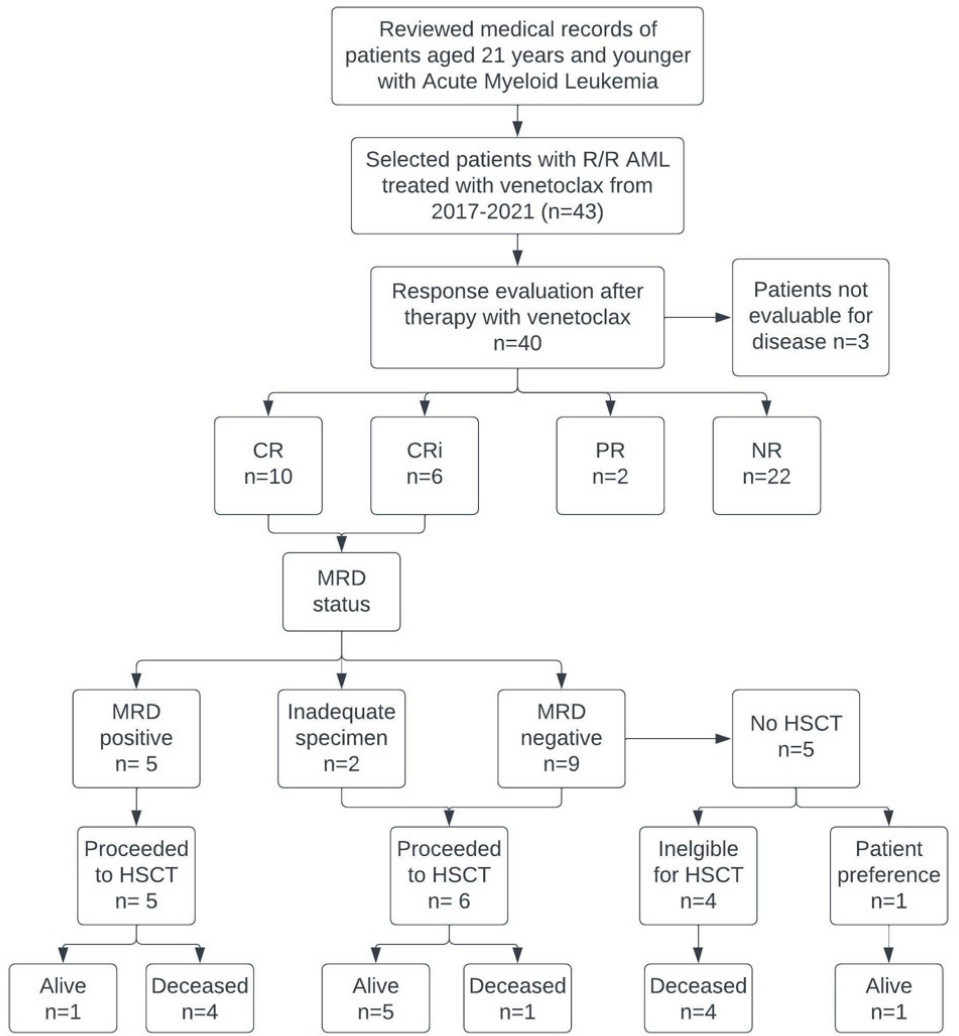
Figure 1. Flow chart for patient ʹ s inclusion criteria and outcome. Flow chart for inclusion and overall outcome. Abbreviations: CR—complete response; CRi—complete response with incomplete blood count recovery; PR—partial response; NR—no response; HSCT—hematopoietic stem cell transplantation; MRD—measurable residual disease; R/R—relapsed refractory.